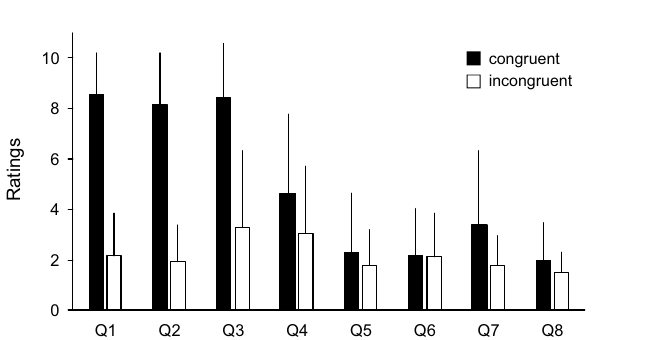
Figure 3. Group means of frequency of electrical stimulation during the rest, congruent, incongruent, and tactile stroking conditions in Experiment 1.